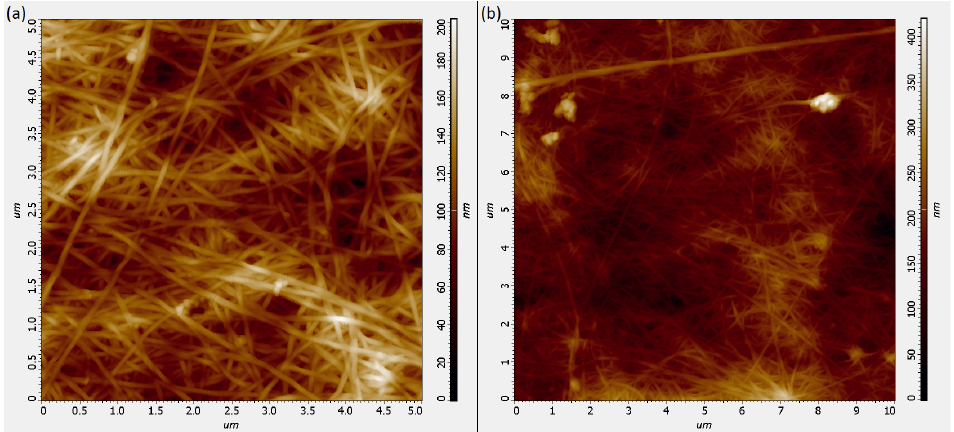
Figure 5. Topography of the BNC sample obtained by Atomic Force Microscopy for 5 × 5 µ m area ( a ) and 10 × 10 µ m area ( b ).